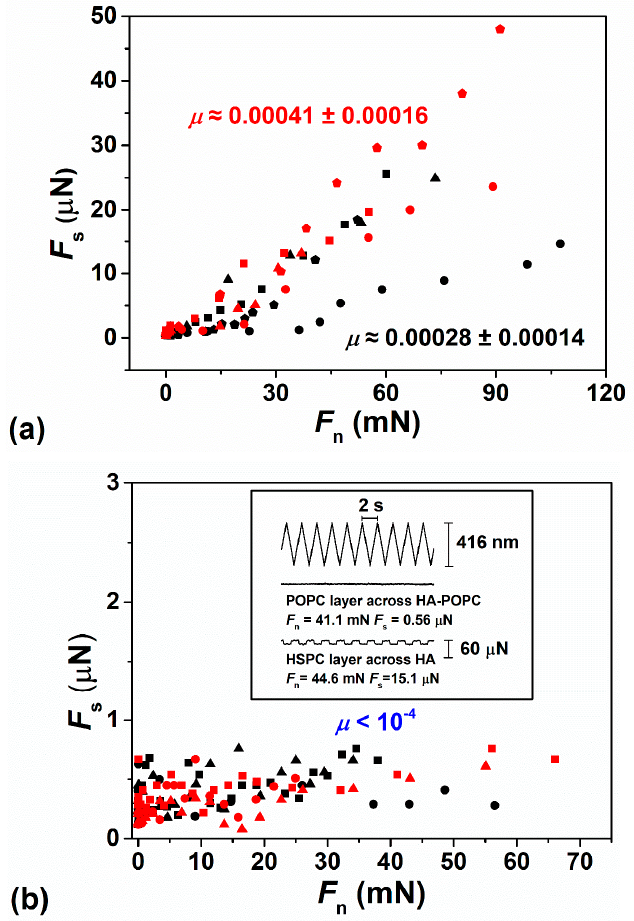
Figure 6. ( a ) Frictional force F s versus F n between two mica surfaces across pure water following overnight incubation with HSPC SUVs dispersion (black symbols), where μ ≈ 0.00028 ± 0.00014, and across HA solution (red symbols), where μ ≈ 0.00041 ± 0.00016. ( b ) Frictional force F s versus F n between two mica surfaces across POPC SUVs dispersion following overnight incubation with POPC SUVs dispersion (black symbols) and across POPC-HA mixture (red symbols), where both of them showed μ < 0.0001. The inset shows directly measured shear traces F s ( t ) for POPC layer across HA–POPC (2nd trace) and HSPC layer across HA (3rd trace) with similar normal force as a function of applied sliding motion (top trace). The low values of F s are determined by fast Fourier transform of the shear traces [12] .